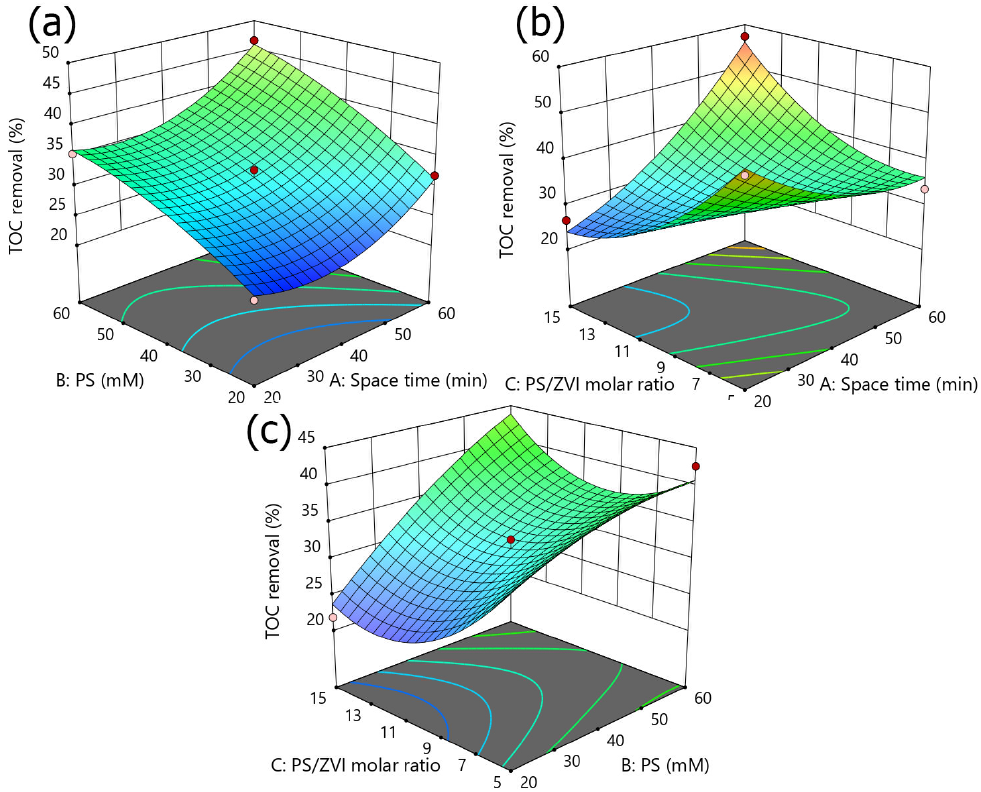
Figure 3. Three-dimensional plots of TOC removal in the continuous flow UV/PS/ZVI process as a function of: ( a ) space time (min) and PS (mM); ( b ) space time (min) and PS/ZVI molar ratio; and, ( c ) PS (mM) and PS/ZVI molar ratio.